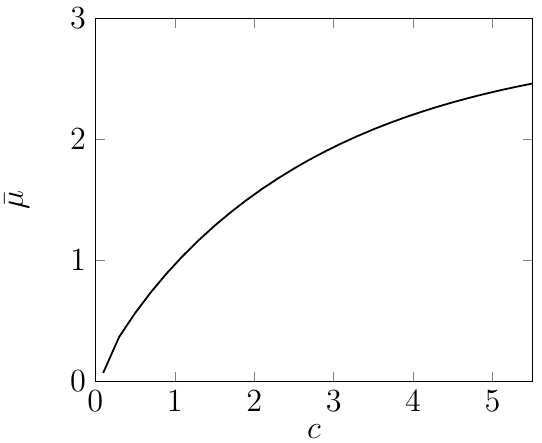
Figure 5: Dependence of the effective chemical potential ¯ µ on the final value of the interac- tion c . At large c , ¯ µ asymptotically approaches the analytically predicted value ¯ µ → 4 (see Appendix B) while it vanishes for small c (shallow quench limit) as expected for the BEC state (ground state of free